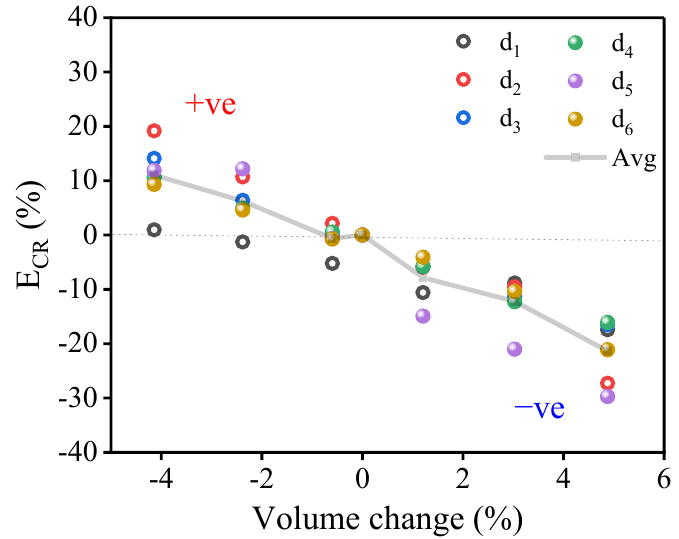
Figure 6. Change rate of the deformed TDE for specific directions in Ta: (d 1 ) [1 1 1], (d 2 ) [1 1 0], (d 3 ) [1 0 0], (d 4 ) [3 2 1], (d 5 ) [1.12 3.8 − 0.5], (d 6 ) [ − 0.441 − 0.086 − 0.894]. Each point represents the average of 20 simulations of different vibrational